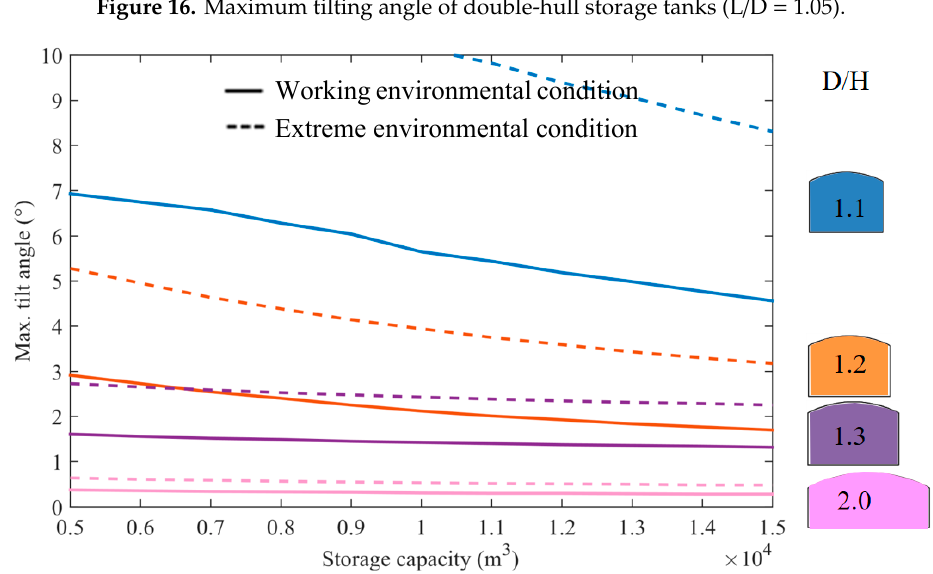
Figure 17. Maximum tilting angle of double-hull storage tanks (L / D = 1.1).